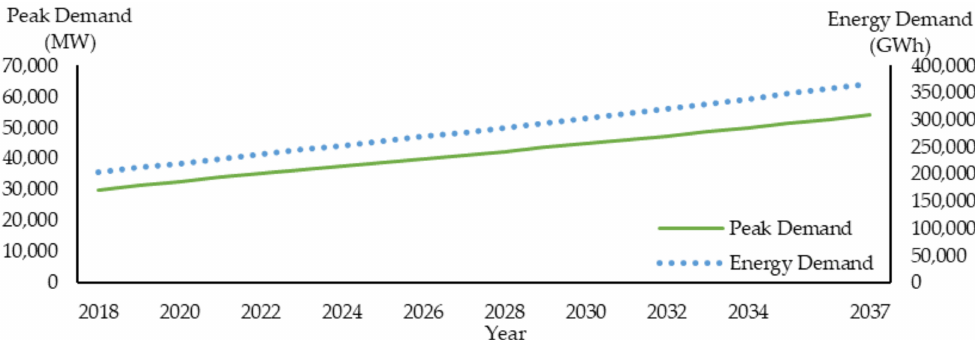
Figure 5. Peak demand and energy demand forecast of